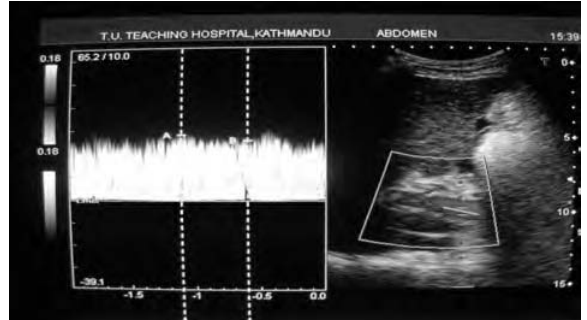
Fig 2. Portal vein wave form in a patient with Cirrhosis (Child C) with portal hypertension: flattened waveform with absent